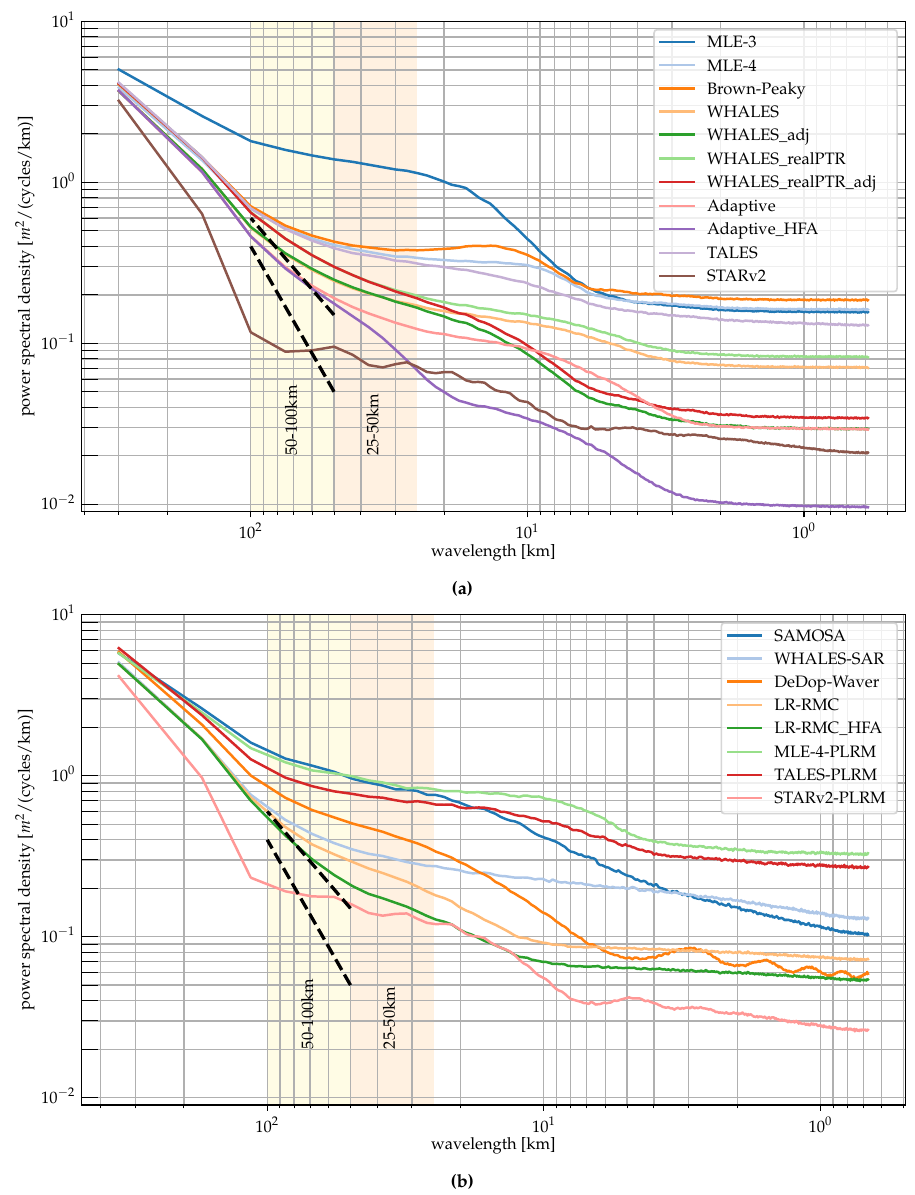
Figure 8. Mean spectra of SWH from the various retrackers, calculated from 1024-point segments using the Welch periodogram method. ( a ) LRM retrackers for J3. ( b ) LRM (applied to PLRM) and DDA retrackers for S3A. The dashed lines indicate the spectral slope associated with processes giving a k − 2 or k − 3